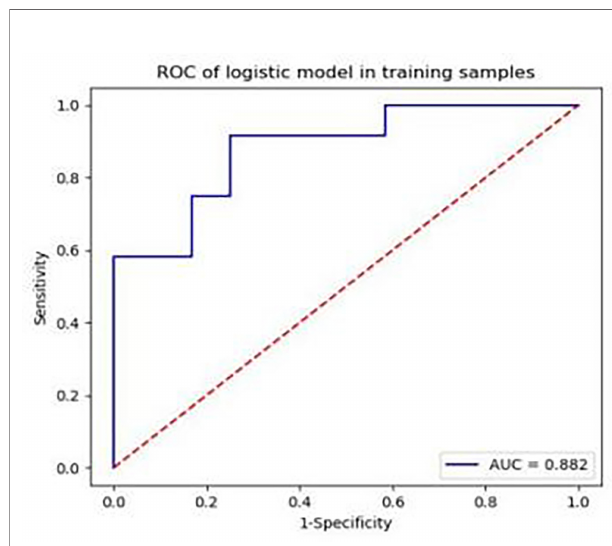
FIGURE 7 | Area under the receiver operating characteristic curve of the diabetic model rabbits with critical limb ischaemia, diagnosed based on K trans texture parameters, is